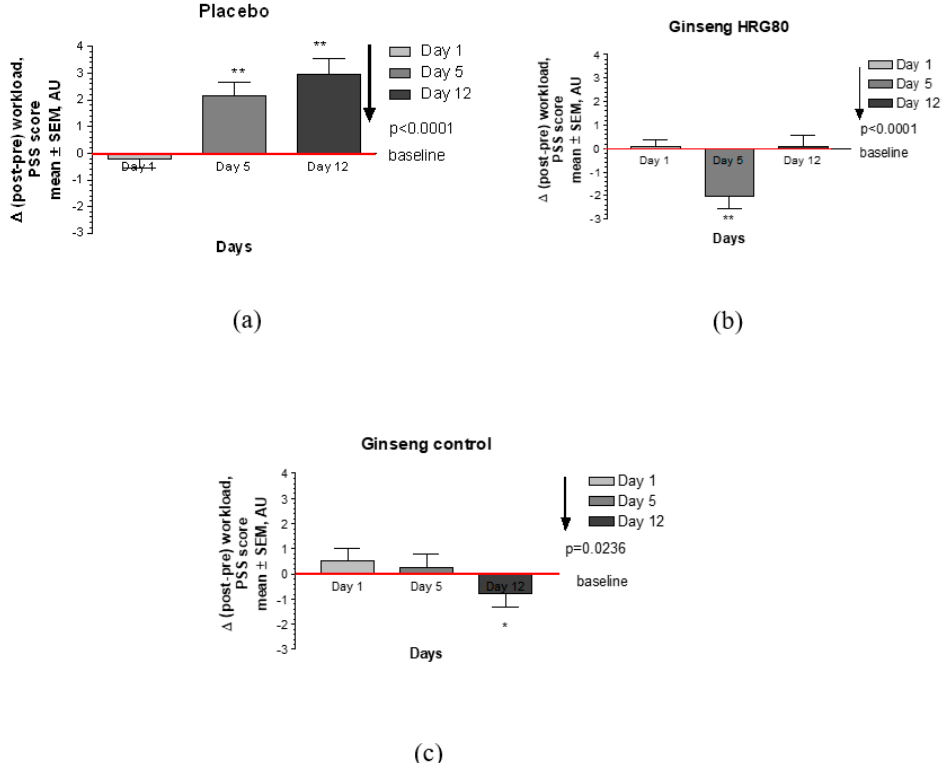
Figure A6. Difference between post- and preperceived stress scores (PSS, mean ± SEM, Y -axis) in memory test at Days 0, 1, 5, and 12 in ( a ) placebo, ( b ) ginseng HRG80, and ( c ) ginseng control treatment groups. Change significance shown by symbols * p < 0.05, ** p < 0.01, *** p < 0.001; ns, not significant. Within-group improvement observed in ginseng groups on Day 5 in HRG80 treatment (Day 5 vs. Day 0) and on Day 12 in ginseng control group; in place group, perceived stress increased over time ( p < 0.001).